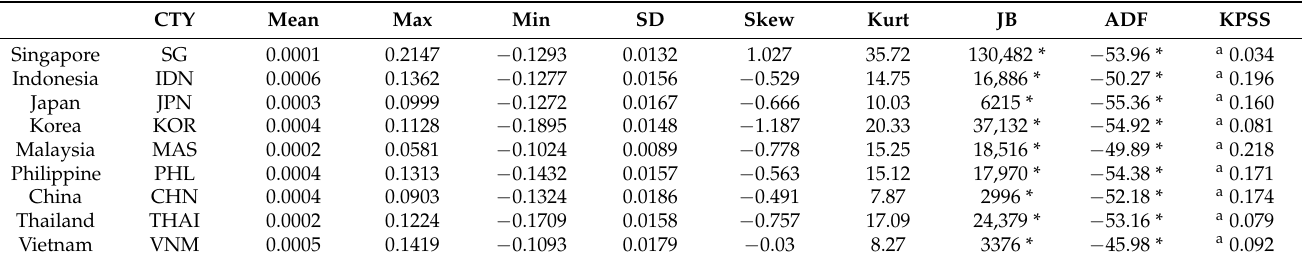
Table 1. Unit root tests and descriptive statistics of stock market indices returns.